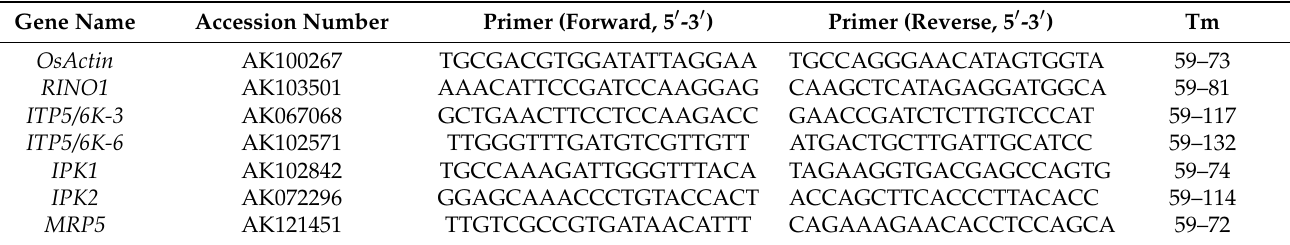
Table 1. Sequence of primers for PA synthesis-related